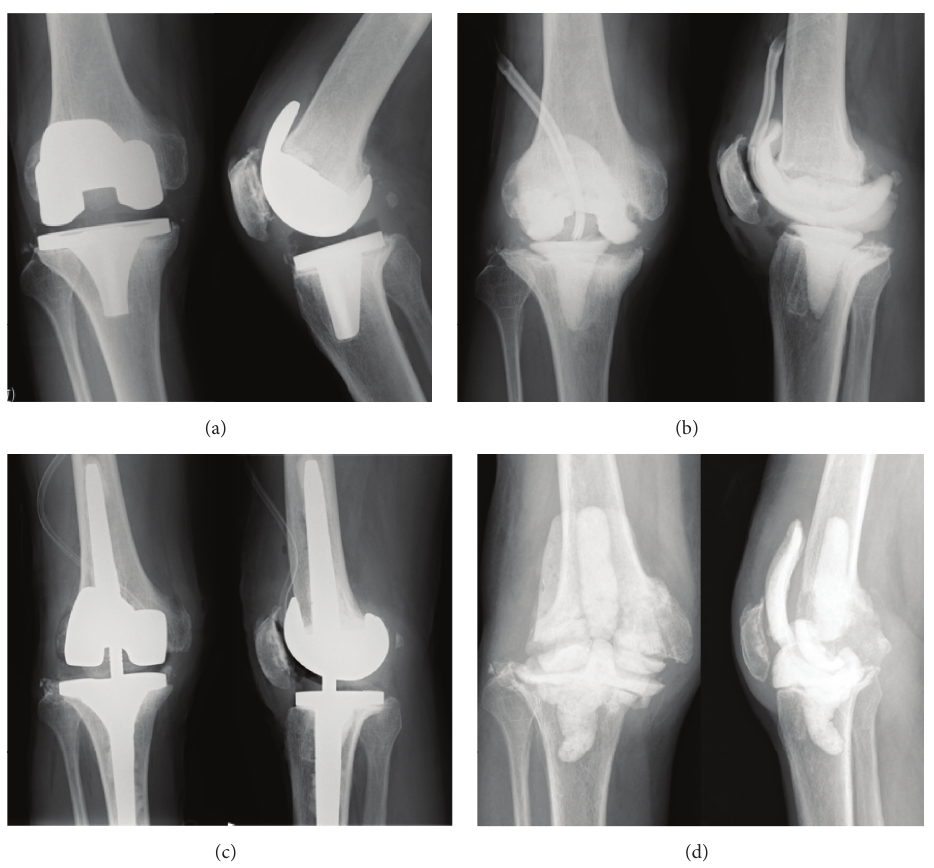
Figure 1: (a) Anteroposterior radiograph of right knee after primary TKA. (b) Anteroposterior radiograph of right knee after first antibiotic- impregnated cement spacer exchange and debridement. (c) Anteroposterior radiograph of right knee after revision TKA. (d) Anteroposterior radiograph of right knee after second antibiotic-impregnated cement spacer exchange and